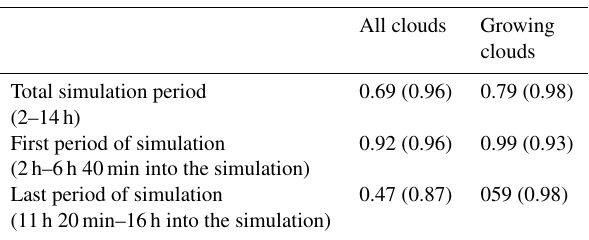
Table 1. Linear regression slope on the η vs. w phase space for the different periods of the simulations for all clouds and growing-stage clouds in the domain. R 2 of the regression lines is presented in